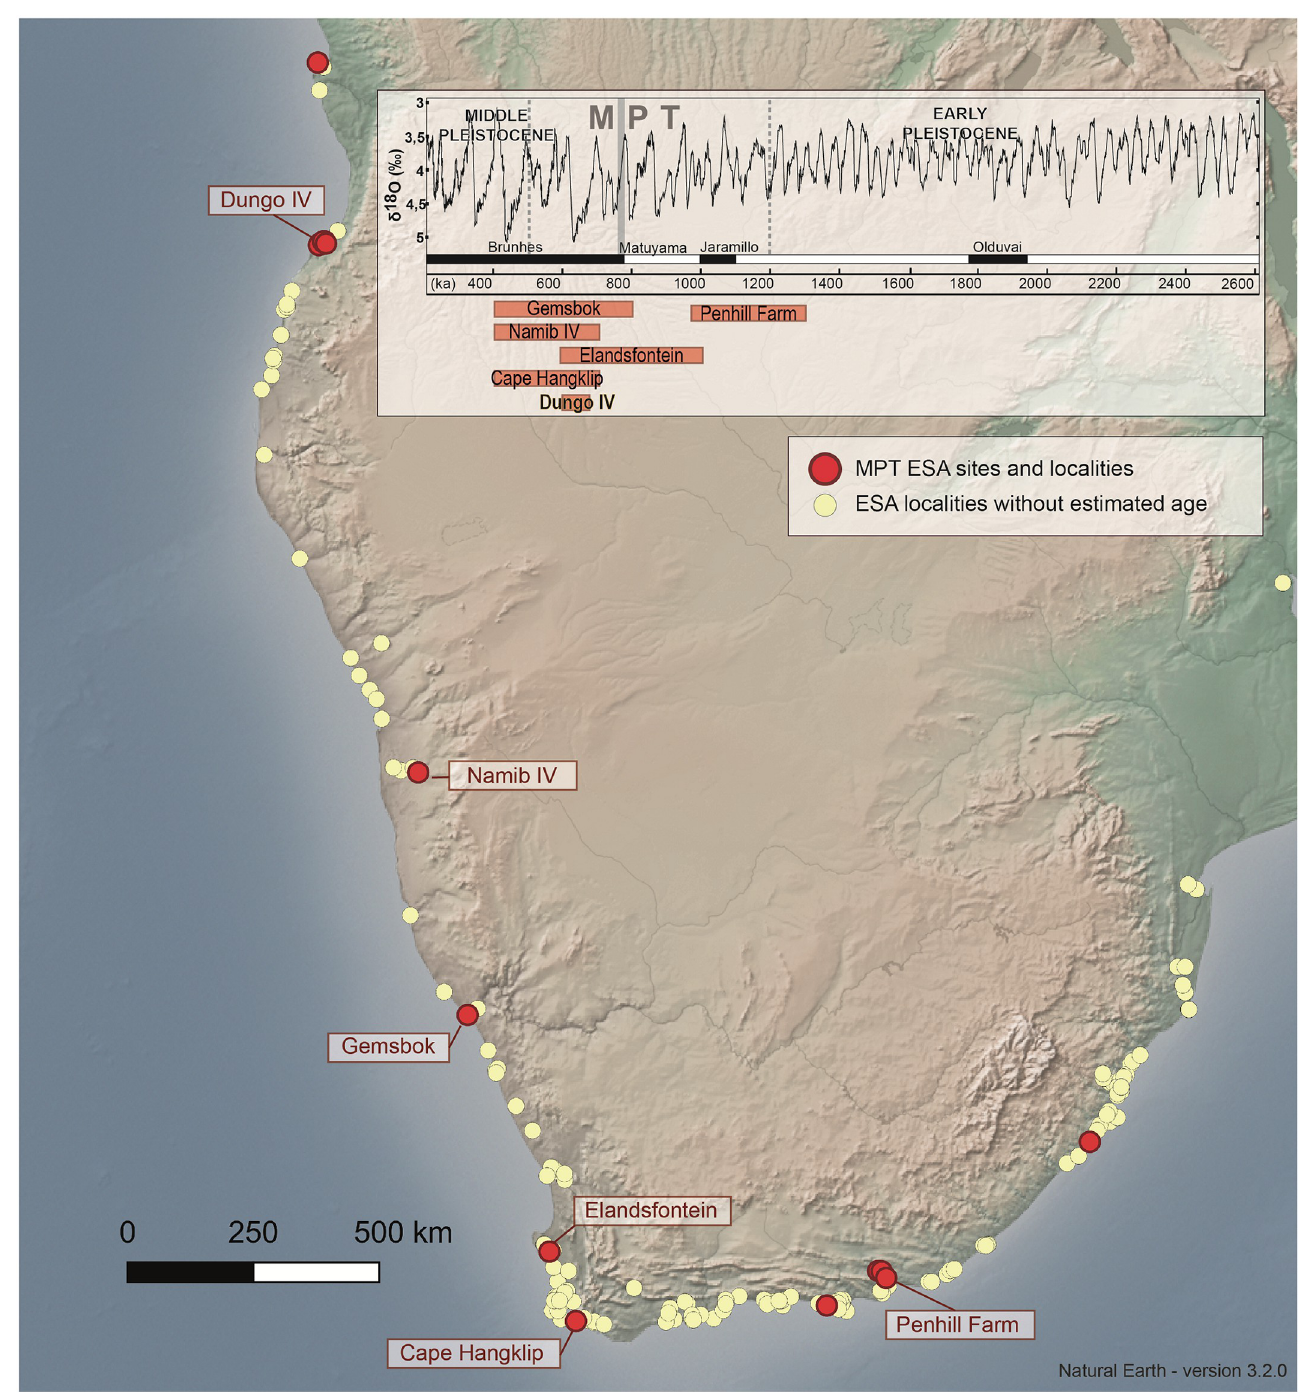
Fig 1. Map and chronology of coastal ESA localities and localization of sites considered in the paper. For details see S1 Table. Reprinted from Natural Earth under a CC BY license, with permission from Natural Earth, original copyright 2022.